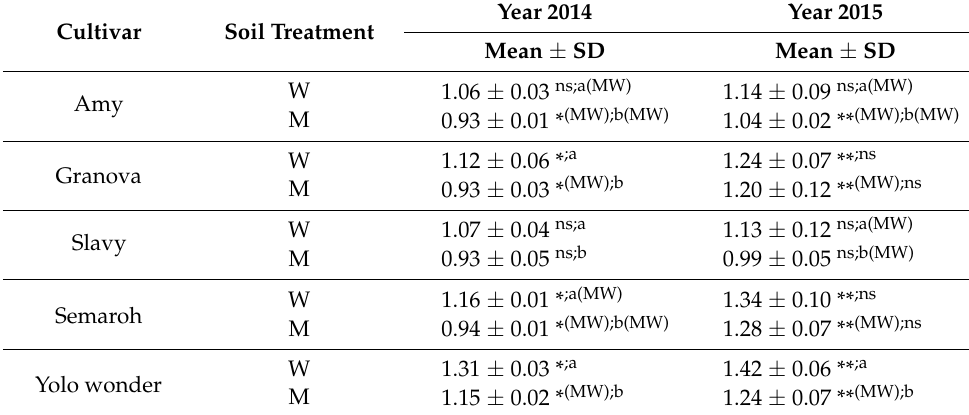
Table 7. Total antioxidant capacity (g AAE · kg − 1 fresh